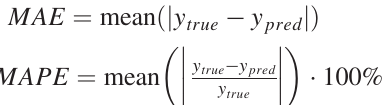
FIG. 19. Submacropulse vertical beam centroid motion at B441PV located 3.59 m downstream of the CM. This is the third panel of Fig. 7 shown with an adjusted vertical scale for the reader ’ s convenience.